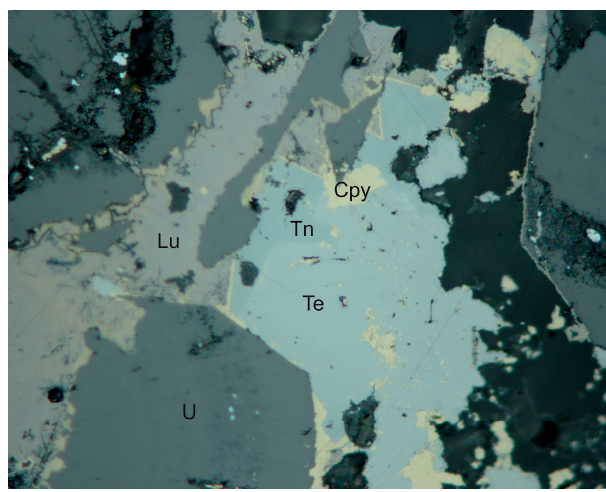
Figure 54. Dark grey Fe-tennantite (Tn) overgrowing grey Fe-tetrahedrite (Te) in association with pinkish luzonite (Lu), chalcopyrite (Cpy), and uraninite (U). Reflected light, one polarizer. FOV 210 μ m. P ř íbram, a dump of the shaft no. 16. Photo P. Škácha.